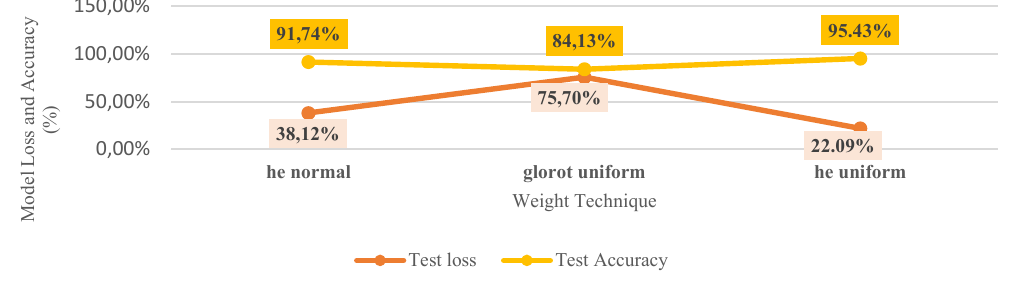
Fig. 6 Impact of various weight techniques on the CNN-RF model (fig share 3C) V. D